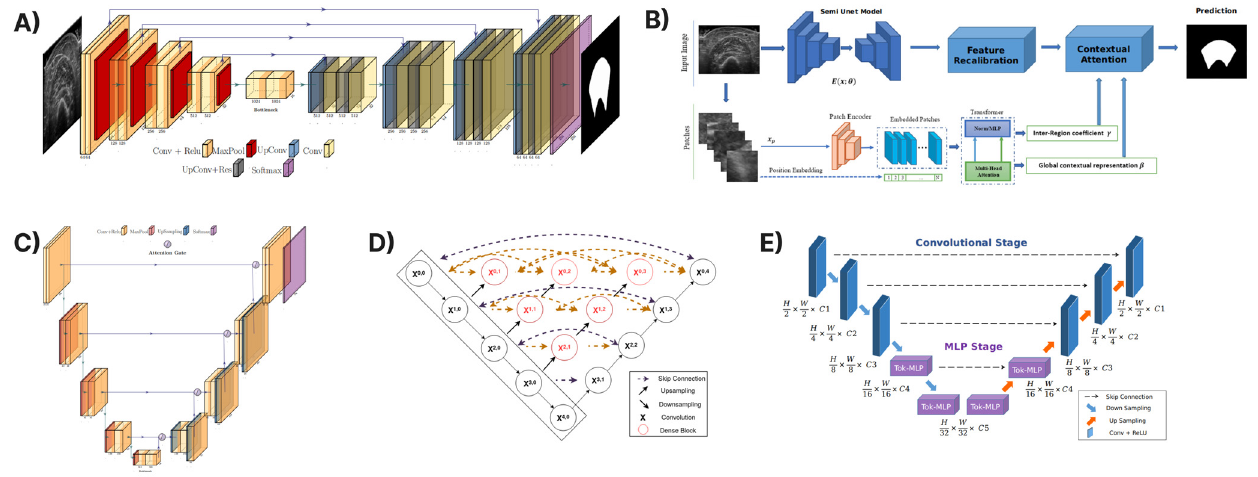
Figure 4. The deep learning architectures used in this study to automatically segment the CSA. In ( A ), the original UNet [17] is depicted; in ( B ), the vision transformer TMUNet [22] is depicted; in ( C ), the Attention-UNet [19] model is depicted; in ( D ), the UNet++ [32] is depicted; and finally, in ( E ), the UNeXt [23] architecture is